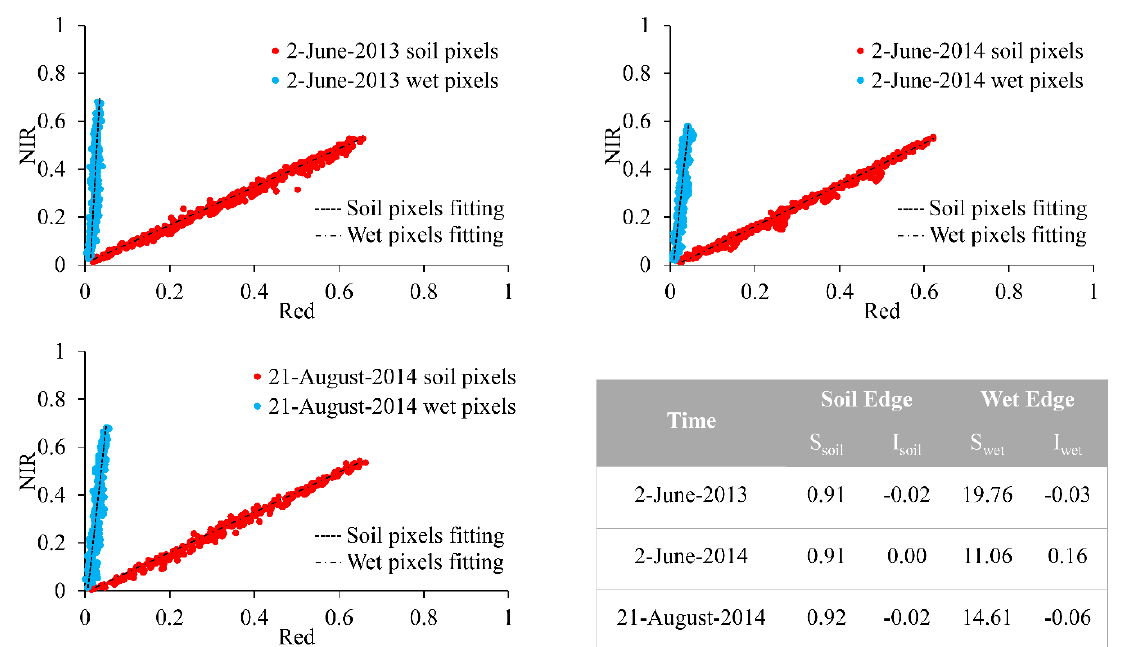
Figure 15. The soil, wet edge pixels, and fitting parameters of the NIR–Red spectral spaces in Xinjiang on three different dates (2 June 2013, 2 June 2014, and 21 August 2014). S soil , I soil are the slopes and intercepts of soil edge, S wet , I wet are the slopes and intercepts of the wet edge.